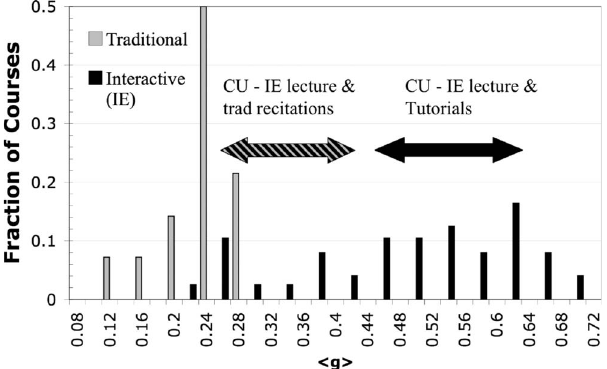
FIG. 3. Plot of normalized learning gains. Data from Hake (cid:1) Ref. 9 (cid:2) show FCI gains (cid:1) background bars. (cid:2) Data for CU are FMCE gains, showing the span of CU interactive engagement (cid:1) IE (cid:2) lectures using tutorials (cid:1) right arrow (cid:2) and IE lectures with traditional recita- tions (cid:1) left arrow (cid:2)